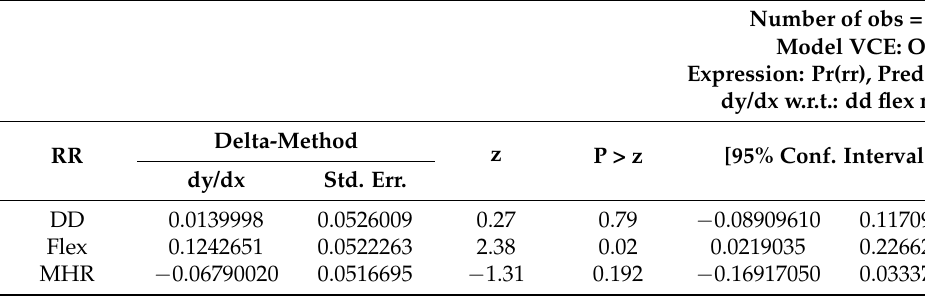
Table 5. Marginal effects with RR as dependent variable.